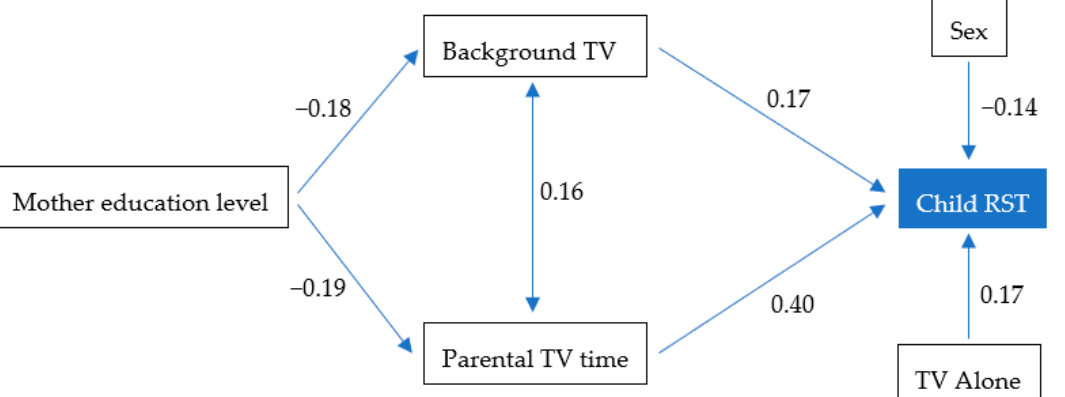
Figure 3. Final Path Model for older group (6–14 years-old) with standardized regression coefficients and correlations between variables. Proportion of variance explained: 27%. Fitting parameters: χ 2 = 6.197, df = 6, p < 0.01; RMSEA < 0.01; CFI = 1; TLI = 1.014. TV, television; RST, recreational screen time; RMSEA, root means square error of approximation; CFI, comparative fit index; TLI, Tacker-Lewis index.